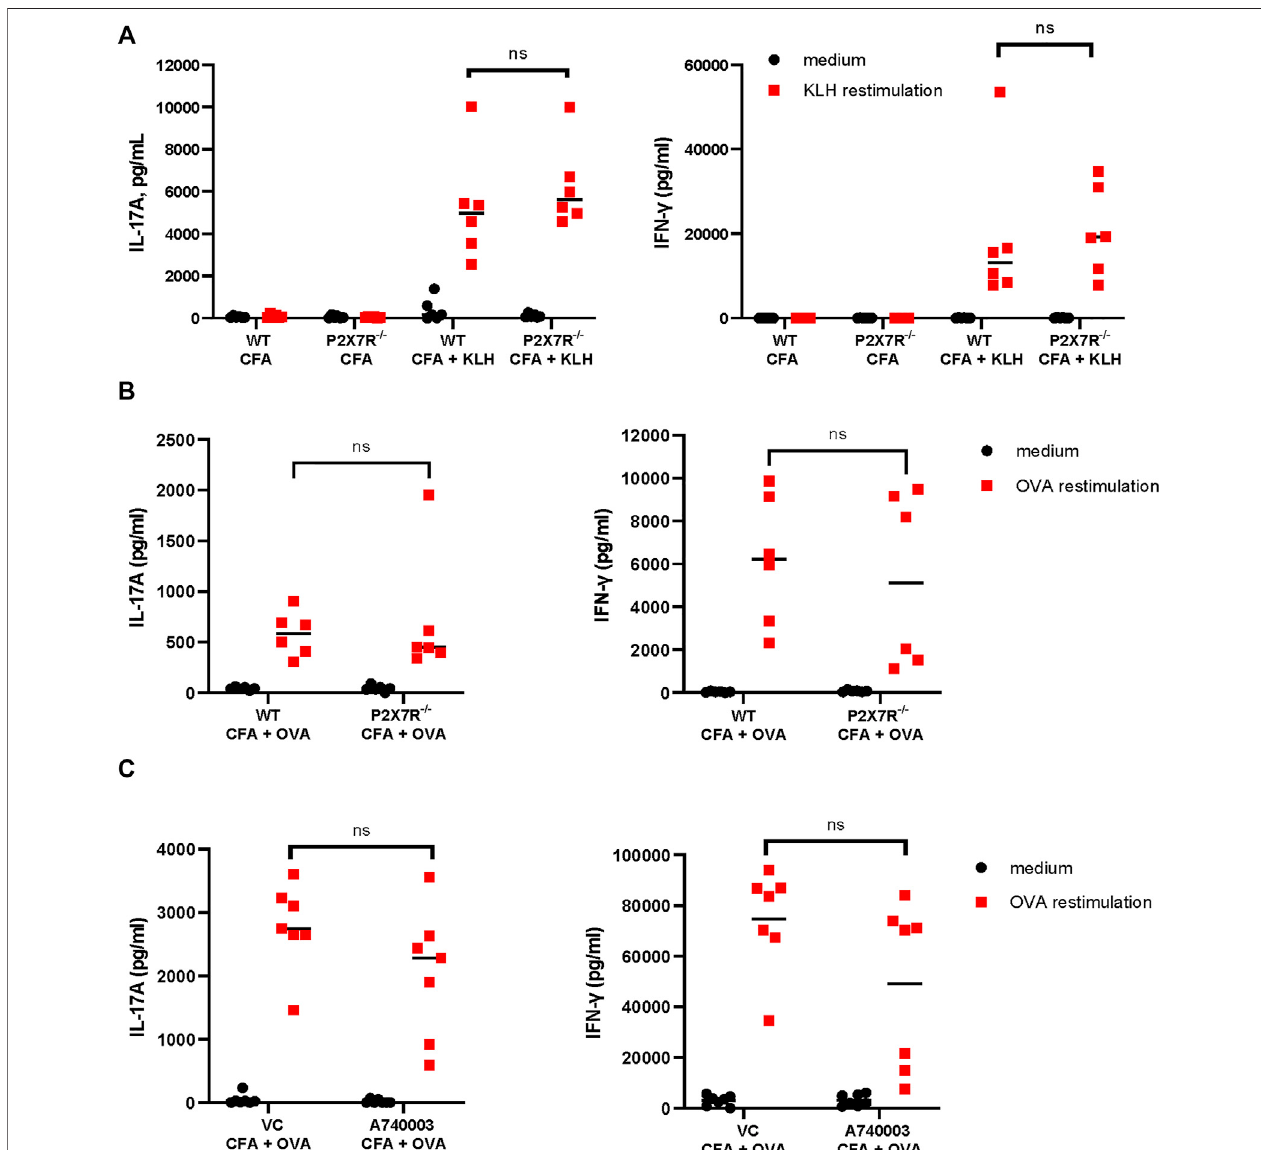
FIGURE 1 | P2rx7 − / − and WT mice mount comparable Th17 responses. (A) WT C57BL/6 mice and P2rx7 − / − mice were immunized with 20 µg of keyhole limpet hemocyanin(KLH) emulsi fi edin complete Freund ’ sadjuvant(CFA).Controlmice weretreatedwithCFAonly.Onday 7inguinallymphnode (LN)cellswerecollectedand restimulated with KLH. On day 3 supernatants were assessed for IL-17A and IFN- γ by ELISA. Results shown are a combination of two independent experiments, with each dot representing an individual mouse. (B) C57BL/6 mice and P2rx7 − / − mice were immunized with 20 µg OVA 323-339 peptide emulsi fi ed in CFA. OVA-speci fi c IL-17A and IFN- γ responses were analyzed as in (A) . Results shown are a combination of two independent experiments, each dot represents an individual mouse. (C) C57BL/6micewereimmunizedwithOVA 323-339 peptideemulsi fi edinCFA,insomegroupsmiceweretreatedwithP2X7Rantagonist,A740003.LNswerecollectedand restimulated with OVA 323-339 peptide as in (A) . Each dot represents an individual mouse from one experiment, LN cells from each mouse were restimulated in 2 – 7 separate wells and then averaged. NS, not signi fi